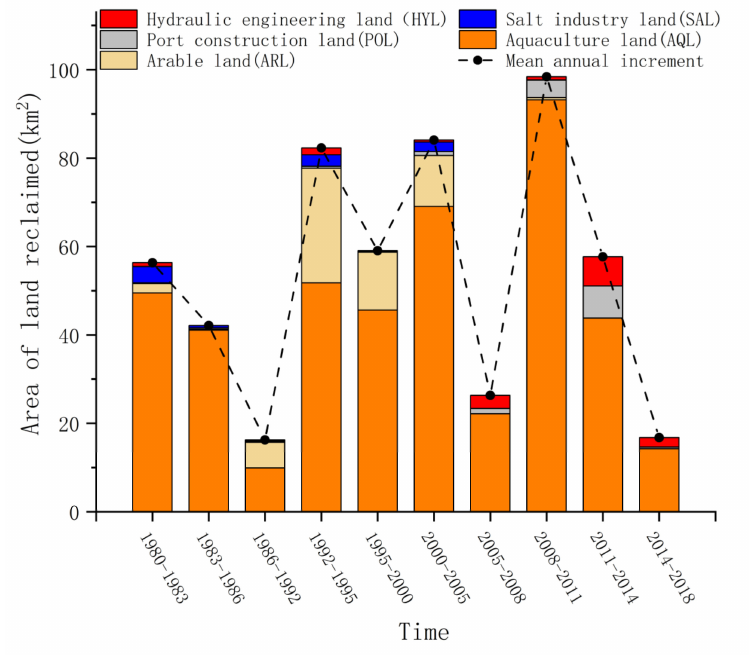
Figure 3. The reclamation process from 1980 to